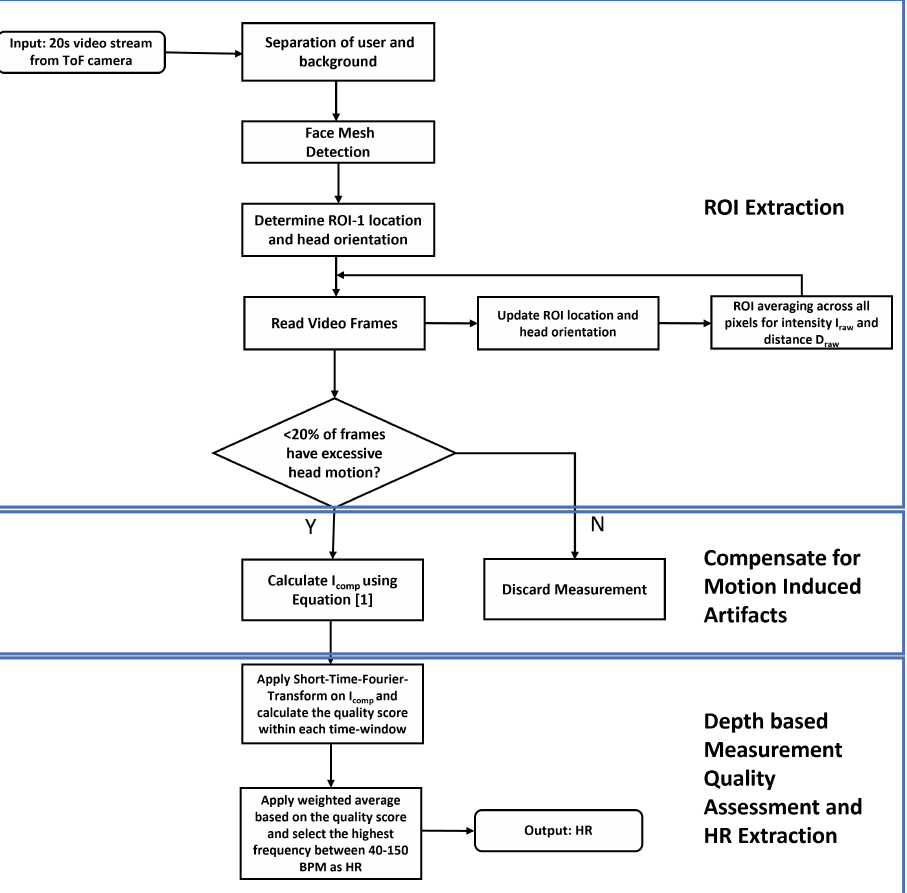
Figure 4. Processes to extract HR while driving using depth and grayscale information from a ToF